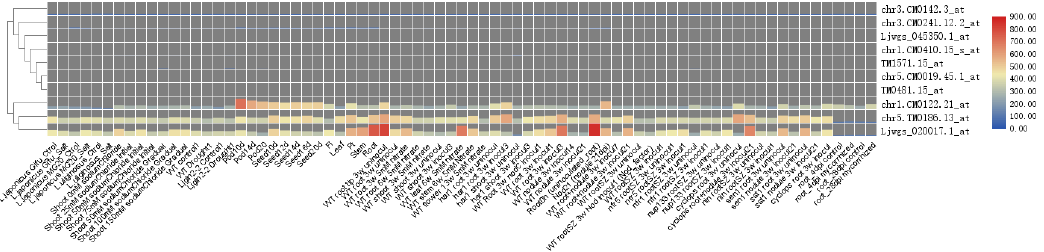
Figure 8. The expression levels of 10 gene probes in this gene family indicate that some genes have higher expression levels in roots, stems and pods, and perhaps the entire gene family plays an important role in plant growth and development.